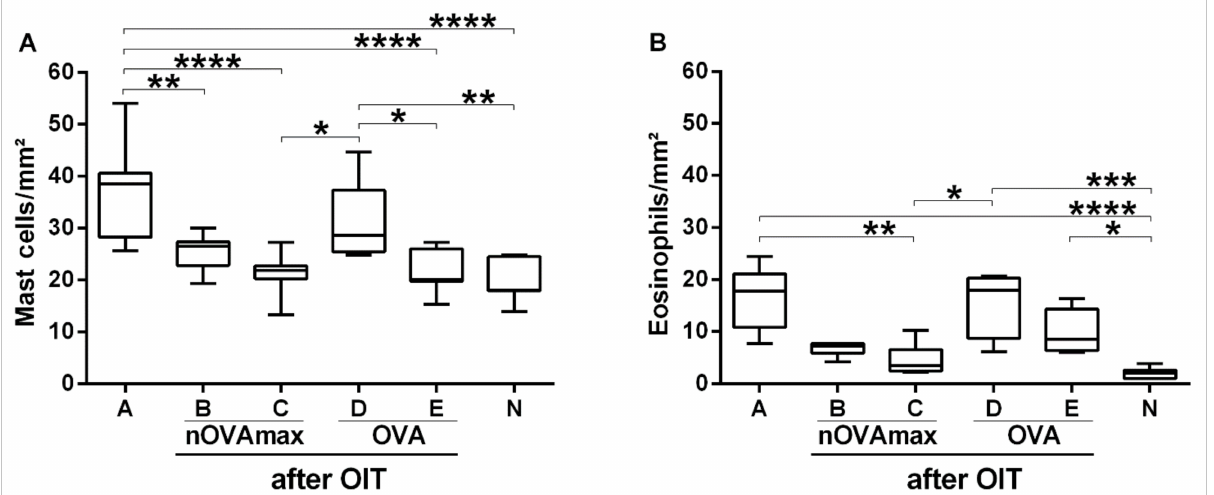
Figure 8. Number of mast cells and eosinophils per mm 2 of gastric antrum tissues. The numbers of mast cells ( A ) and eosinophils ( B ) were normalized to the size of the evaluated tissue. All the results for mast cells were calculated with ANOVA combined with Tukey’s post-hoc test, for eosinophils— with the Kruskal–Wallis non-parametric test and Dunn’s multiple correction test (* p < 0.05, ** p < 0.01, *** p < 0.001, **** p <